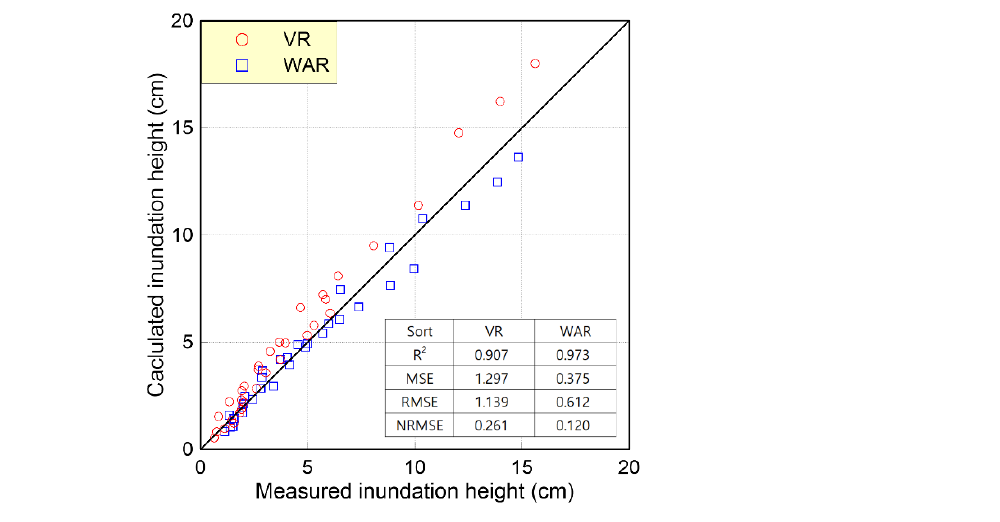
Figure 14. Scatter plot between experimental and calculated values of maximum inundation height.